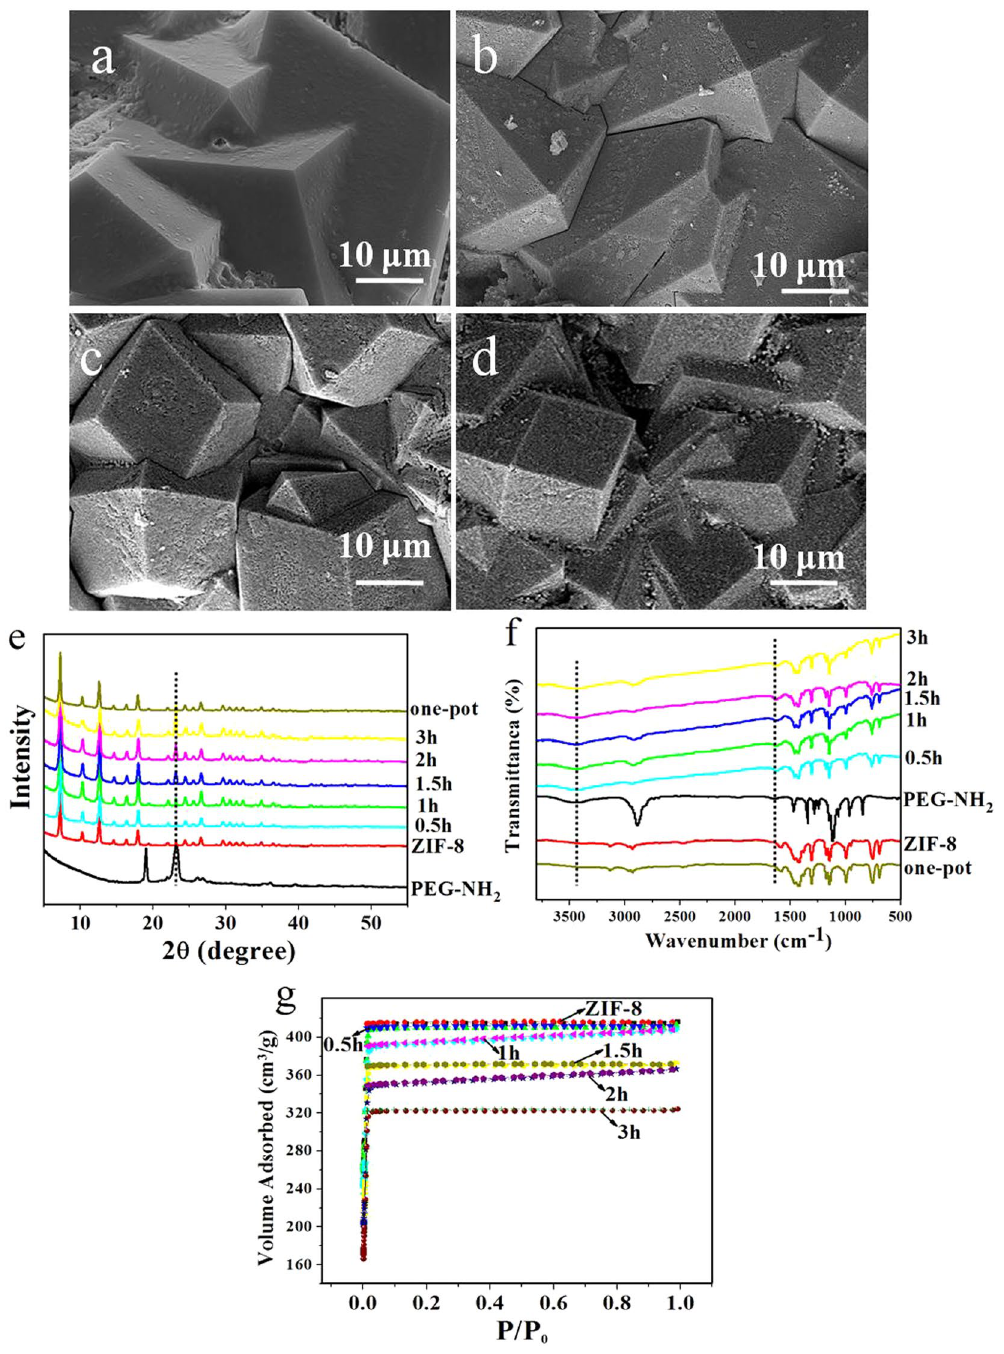
Figure 4. SEM images ( a – d ) of the prepared ZIF-8/PEG-NH 2 composites. Reaction time: ( a ) 0.5 h, ( b ) 1 h, ( c ) 1.5 h, ( d ) 2 h. XRD patterns ( e ), FT-IR spectra ( f ) and N 2 adsorption–desorption isotherms ( g ) of the prepared ZIF-8/PEG-NH 2